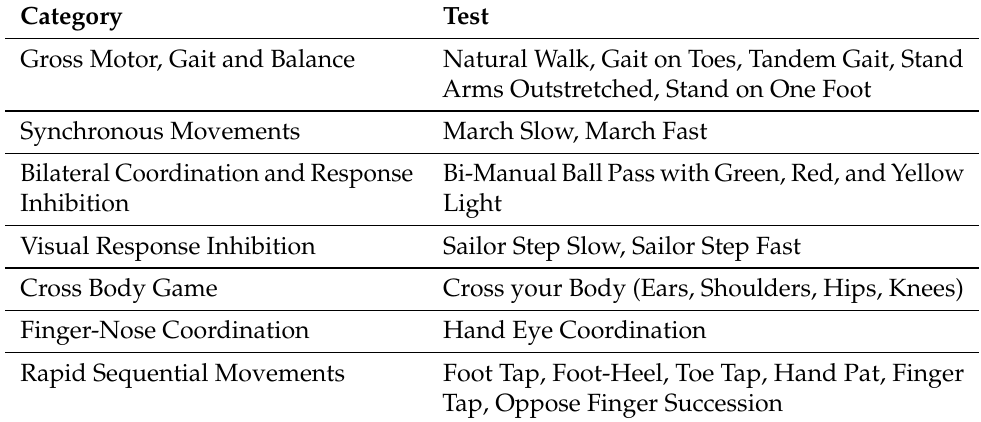
Table 1. ATEC tasks to assess various cognitive